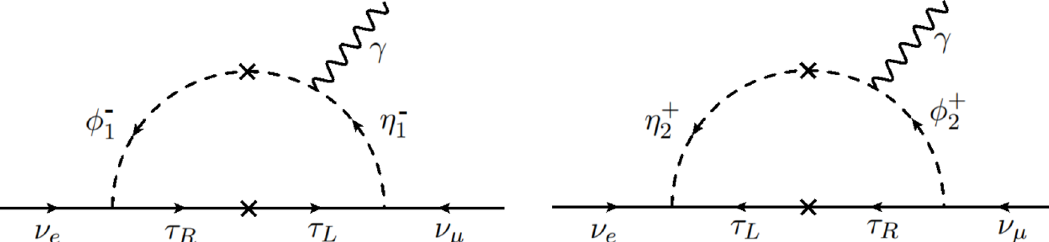
in the SU(2) H e (cid:23) (cid:22)